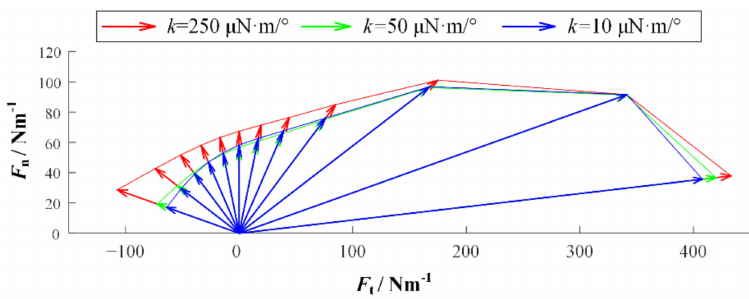
Figure 4. The structure diagram of the simulated model.